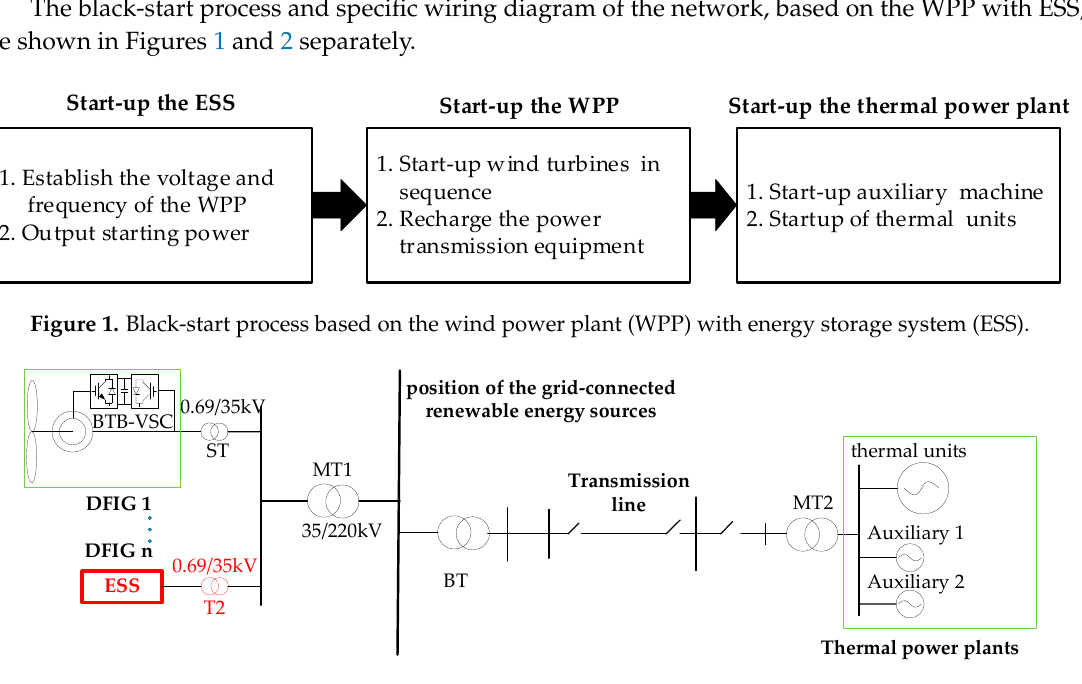
Figure 2. Structure diagram of wind-storage generation system in the black-start.